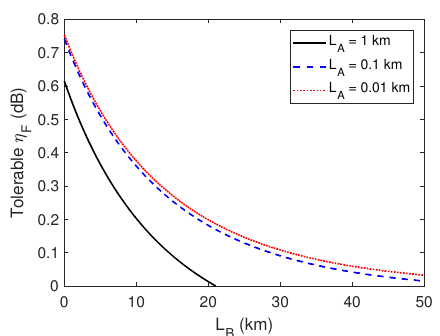
Figure 7. The tolerable insert loss of FIFO when fixing the distance between Alice and Charlie. The black solid line represents the result of L A = 1 km. The blue dashed line represents the result of L A = 0.1 km. The red dotted line represents the result of L A = 0.01